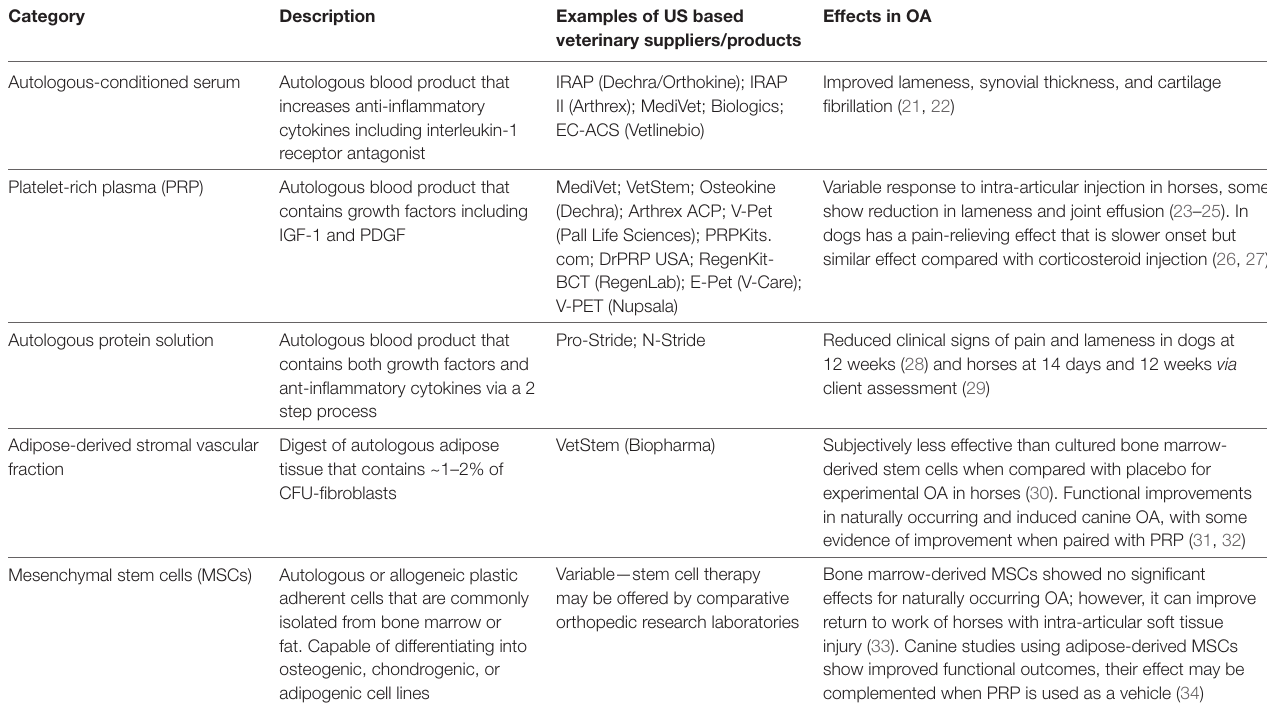
TABLe 1 | Regenerative medicine products used in the dog and horse for